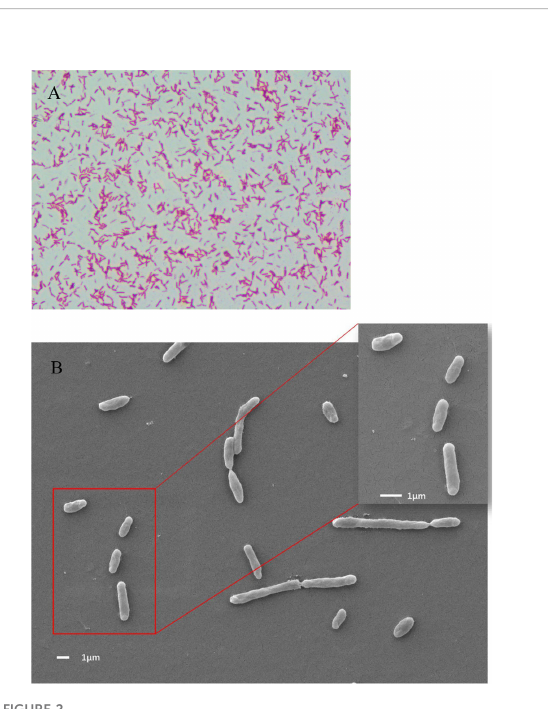
FIGURE 2 Morphology of XX2021 observed under an optical microscope at 100× magni fi cation and a scanning electron microscope. (A) Bacteria (XX2021) were found to be gram-negative under optical microscopy; (B) Most isolated bacteria were rod-shaped and lacked a fl agellum. The diameter of XX2021 was approximate 0.8 m